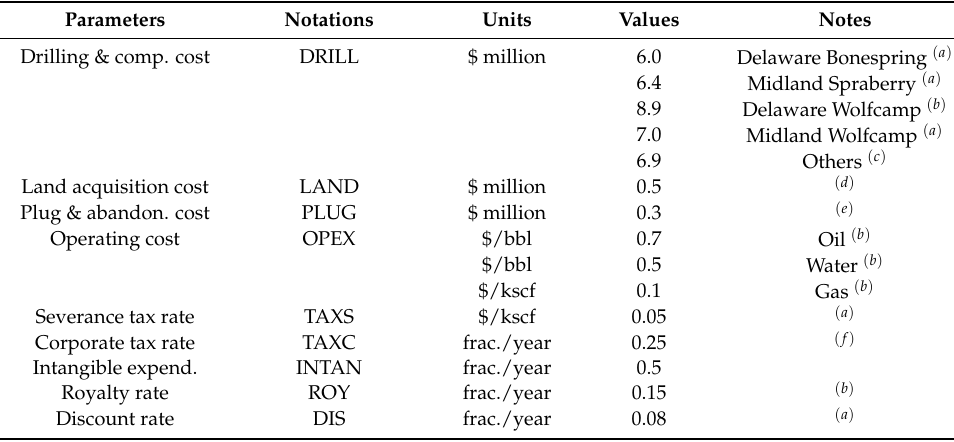
Table 4. Parameters used to calculate NPV in the Permian basin.